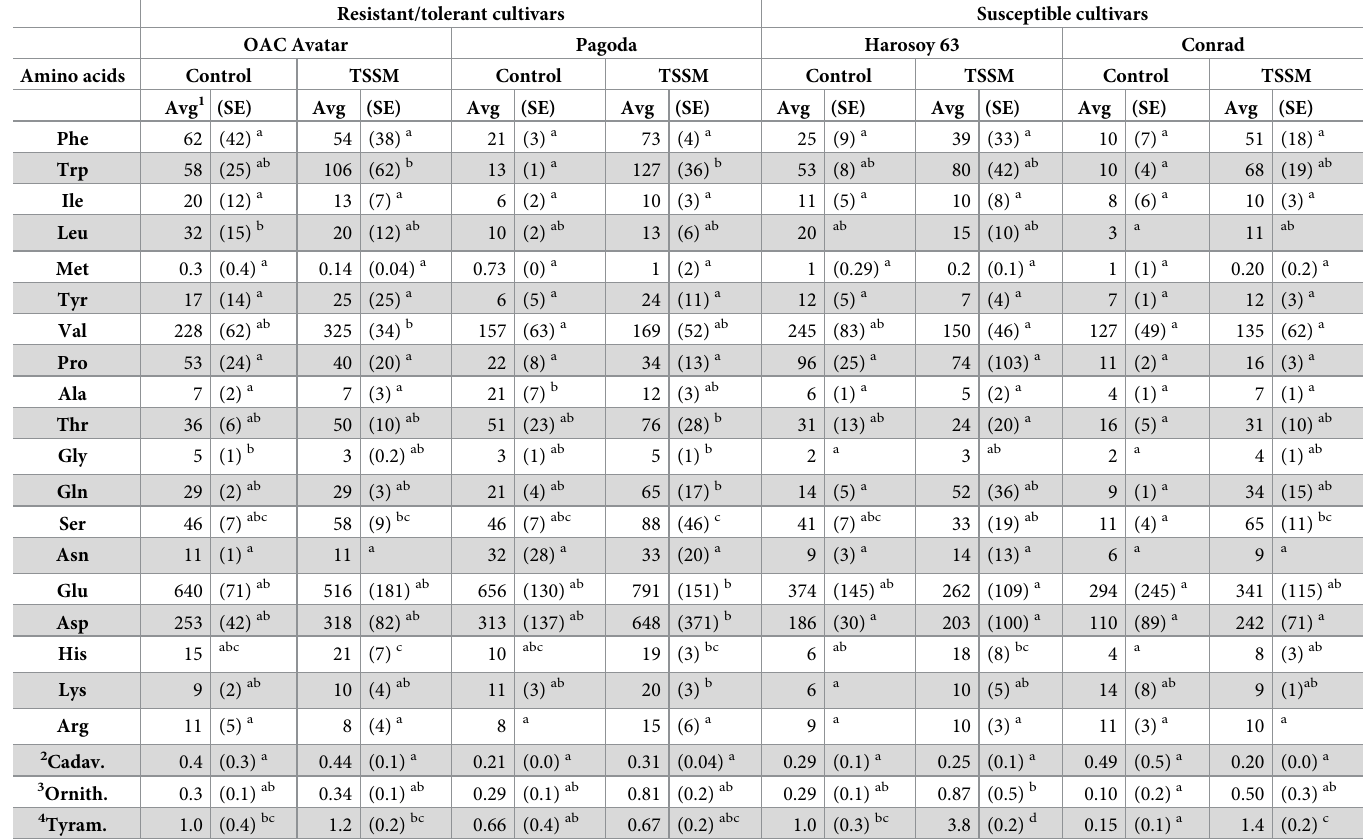
Table 5. The effect of two-spotted spider mite feeding on amino acid concentrations in leaves of 2 resistant and 2 susceptible soybean cultivars after 4 weeks. Resistant/tolerant